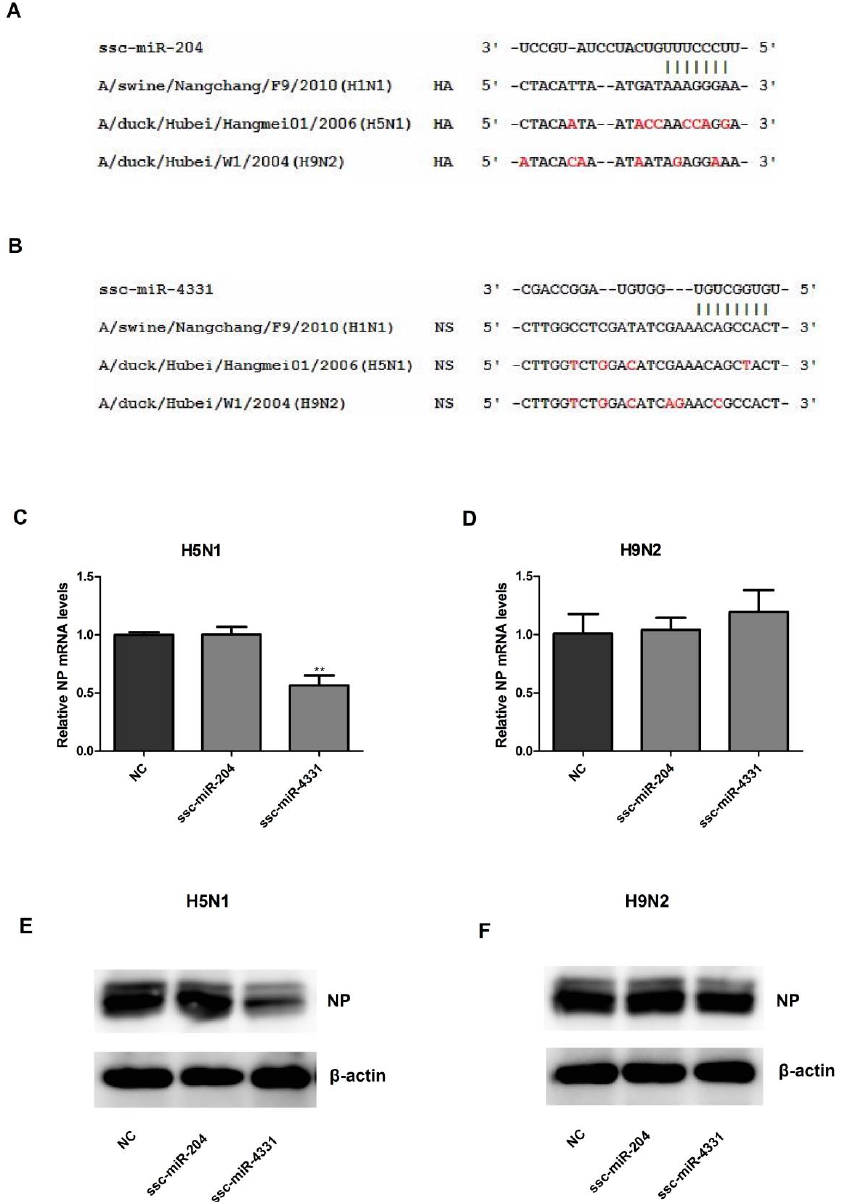
Figure 5. The effect of ssc-miR-204 and ssc-miR-4331 on the replication of H5N1 or H9N2 influenza A virus. ( A ) Sequence alignments of ssc-miR-204 and its target sites in viral HA of three subtypes of influenza A virus (H1N1, H5N1 and H9N2); ( B ) Sequence alignments of ssc-miR-4331 and its target sites in viral NS of three subtypes of influenza A virus (H1N1, H5N1 and H9N2). NPTr cells were transfected with ssc-miR-204 or ssc-miR-4331 for 24 h, then infected with H5N1 or H9N2 influenza A virus for 24 h. The mRNA levels of H5N1 NP ( C ) or H9N2 NP ( D ) were assessed by qRT-PCR method. All data were determined using 2 −ΔΔ C t and normalized to GAPDH. Significant levels were analyzed by Student’s t -test, ** p ≤ 0.01. The protein levels of H5N1 NP ( E ) or H9N2 NP ( F ) were assessed by western blotting. NP expressions were normalized to β-actin.